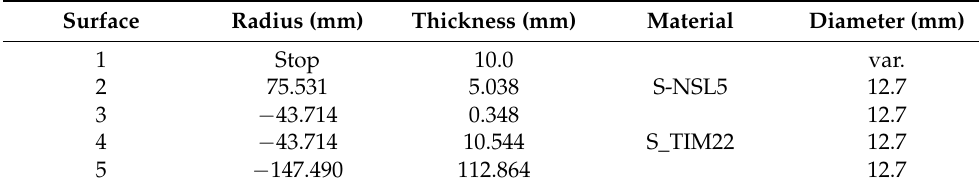
Table 2. Data of the generic Double-Gauss type camera lens we used. Its focal length is 35